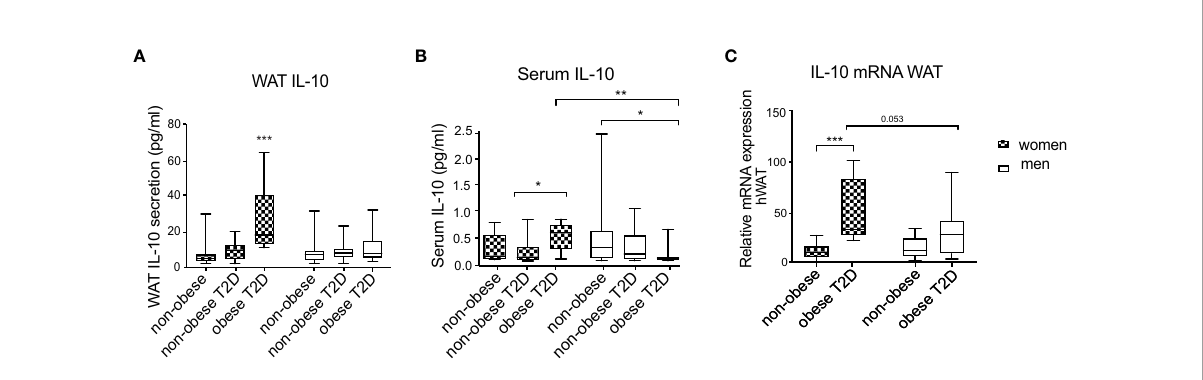
FIGURE 1 IL-10 secretion and mRNA expression in scWAT and serum of men and women. Three metabolic groups (non-obese healthy, non-obese T2D and obese T2D) of both women and men are represented by box plots. IL-10 secretion in WAT explants (A) , circulating serum IL-10 (B) and IL10 mRNA expression in scWAT (C) are shown. Two-way ANOVA with Tukey ’ s and Sidak ’ s multiple comparisons were used in (A – C) to compare between the groups in men and women and to compare the groups between men and women, respectively. Patients from cohort 1 have been used for this analysis and number of individuals per group corresponds to Table 1, *** <0.001, ** <0.01, * <0.05